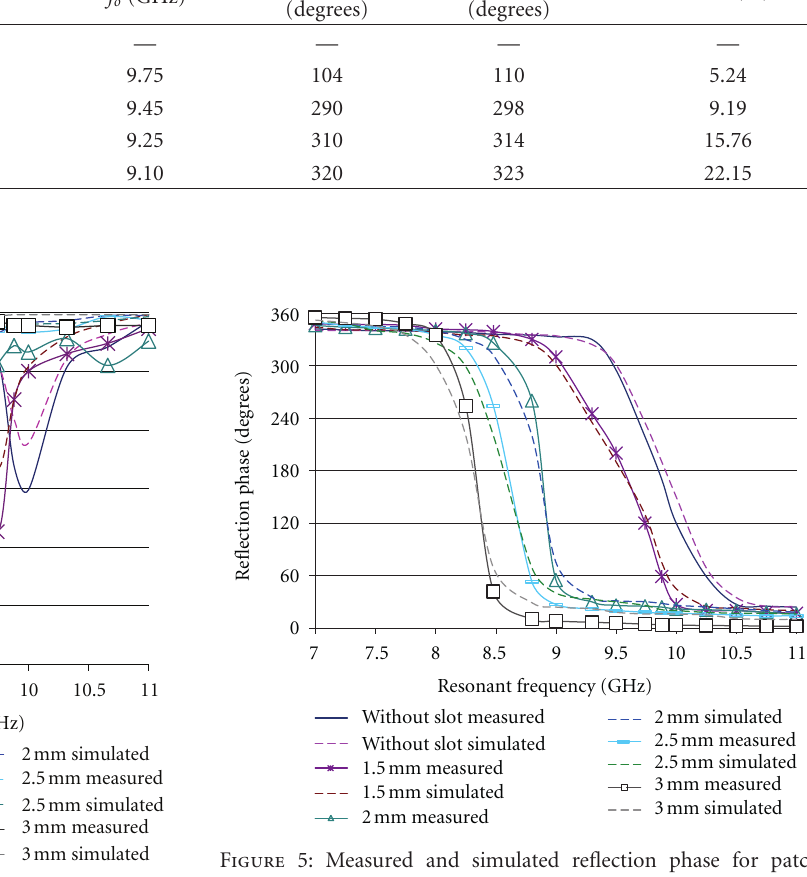
Figure 4: Measured and simulated reflection loss for patch without slot and patch with di ff erent radius of circular slots in the centre of patch.